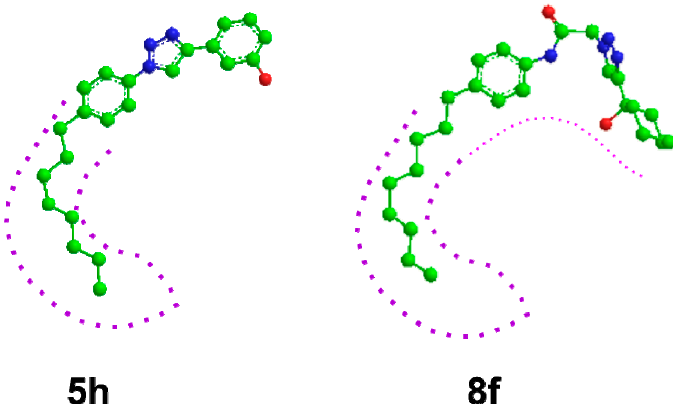
Figure 3. Comparison of the molecular models of inhibitors 5h and 8f . The outline of the “J” site, typical of the SphK1 isoform active site is superimposed to both models. In the case of the 8f model, the outline is prolonged to show the good complementarity with the shape of the active site.